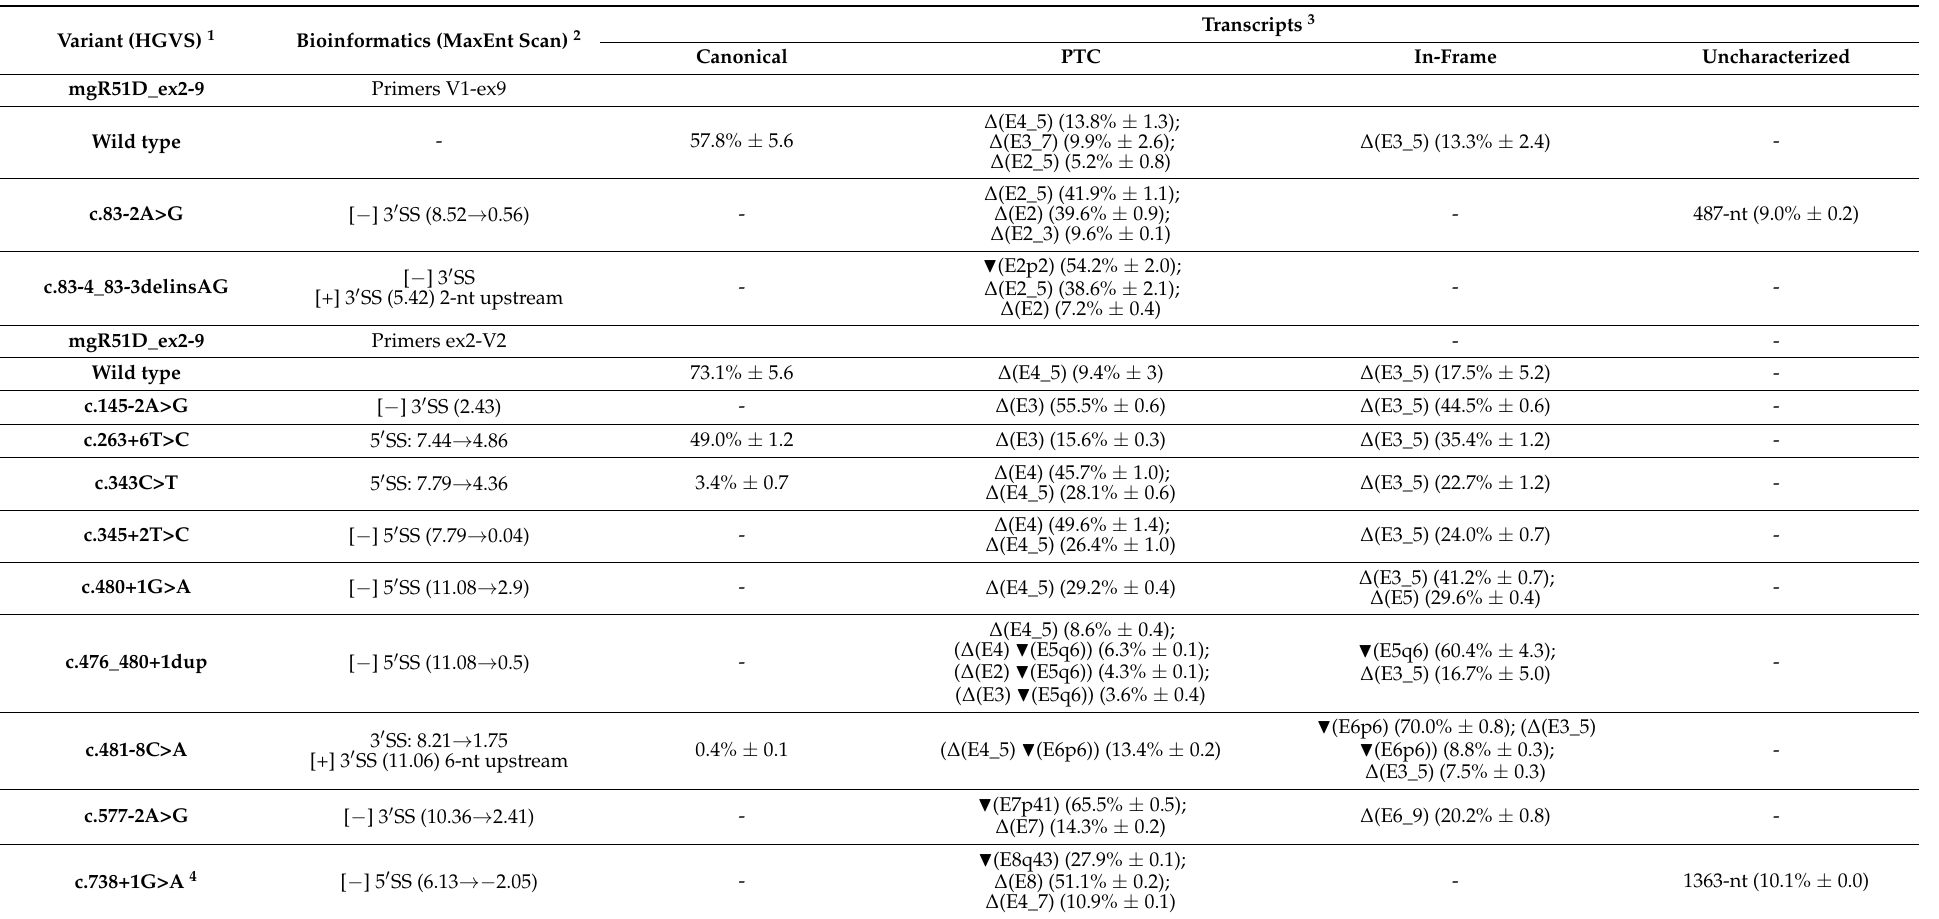
Table 1. Bioinformatics analysis and splicing outcomes of RAD51D canonical splice